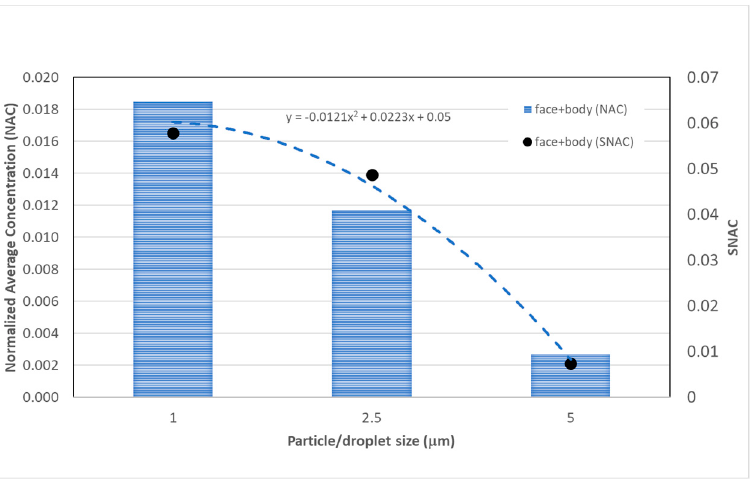
Figure 12. Variation of ( NAC ) and ( SNAC ) with particle/droplet size.